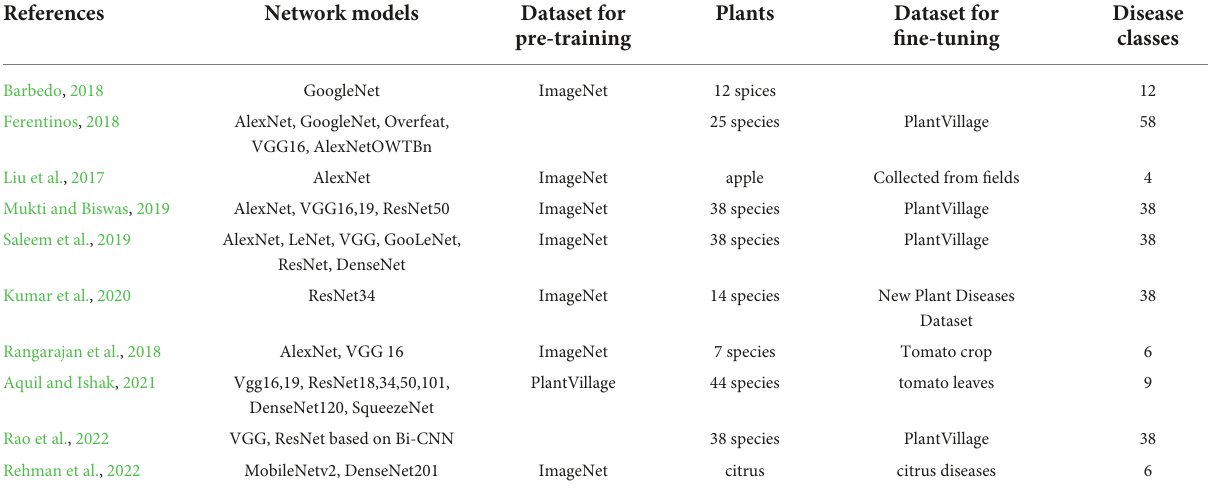
TABLE 1 Deep neural network (DNN)-based classification approaches for identification of plant